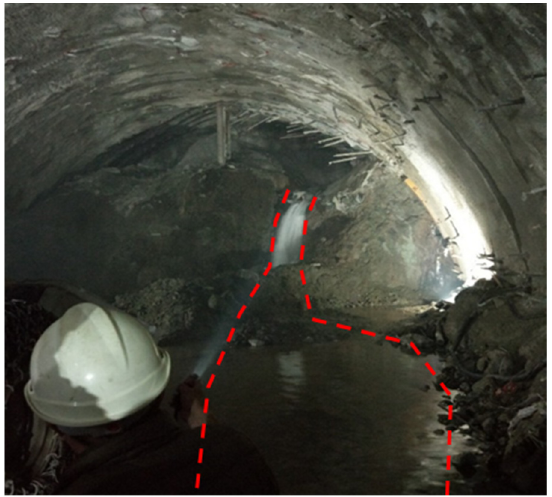
Figure 13. Water surge of tunnel surrounding rock on site.